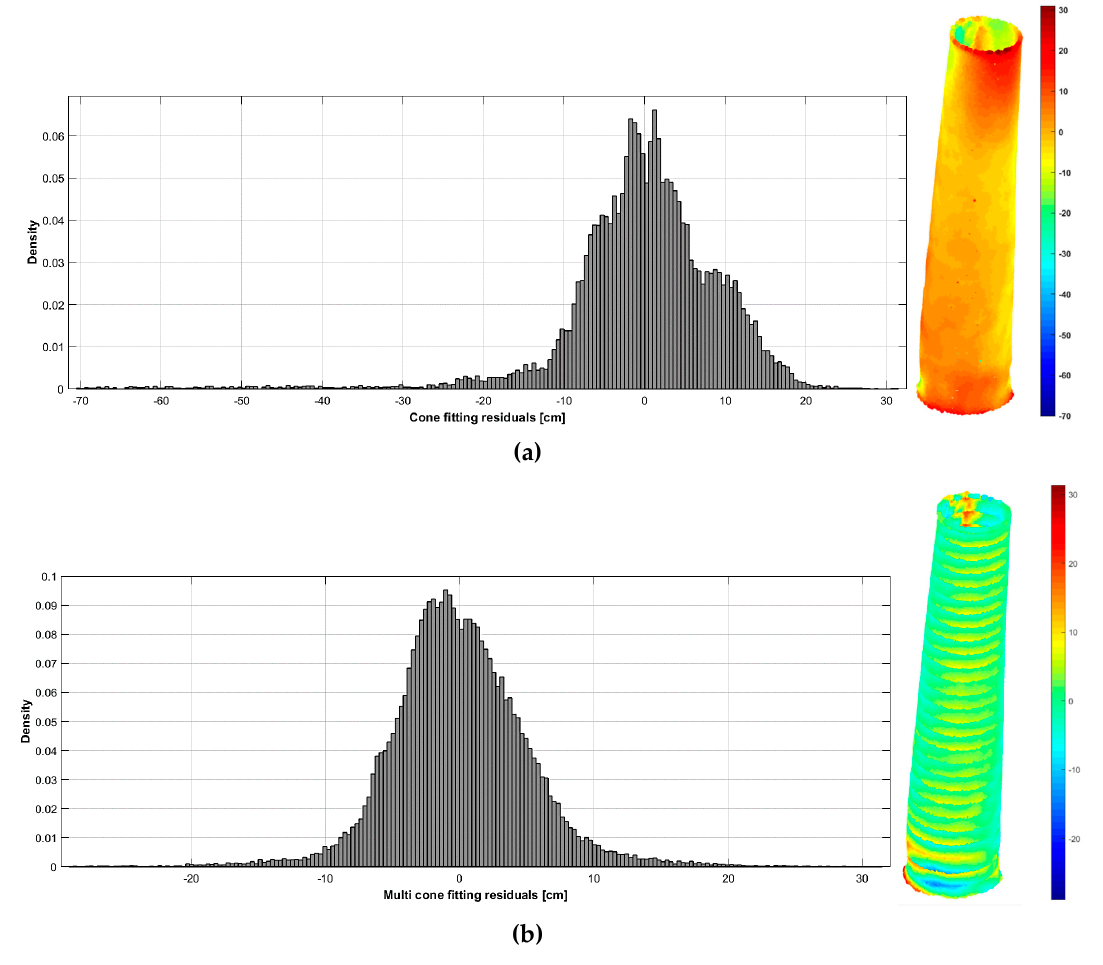
Figure 18. The conical geometric primitive fittings applied to the lost heritage minaret. ( a ) One cone fitting for the whole minaret point cloud. ( b ) Multi section cone